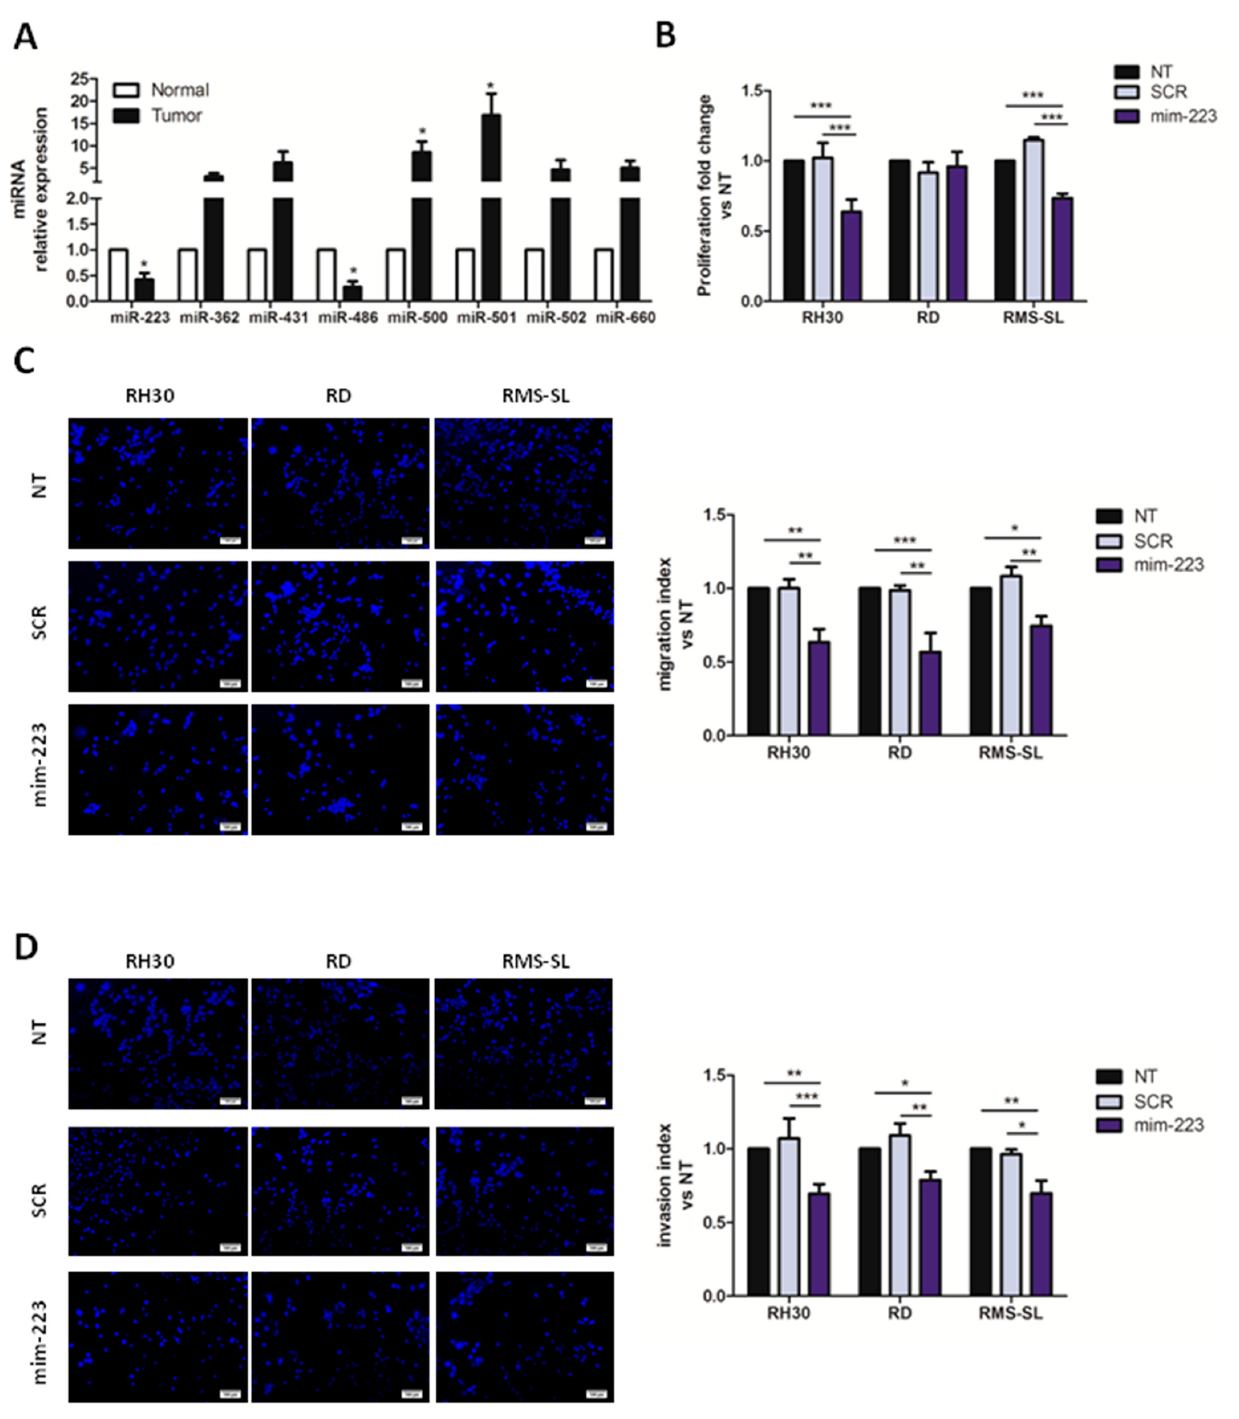
Figure 1. Mir-223 replacement inhibited RMS proliferation and migration. ( A ) Histogram showing miRNAs expression levels in RMS cancers compared to distant normal tissues ( n = 9). * p < 0.05 vs. normal tissues. ( B ) Graph shows cell proliferation of miR-223 over-expressing cells compared to SCR and untreated (NT) control cells ( n = 5). ( C , D ) Representative images and graphs showing of migrated and invaded cells, respectively. MiR-223 reduced migratory ( C ) and invasive ( D ) capacity of adolescent RMS cells in Transwell assay ( n = 5). Migration and invasion data are expressed as number of migrated mir-223 over-expressing cells vs. the number of SCR and untreated (NT) control cells. All data are expressed as mean ± standard error of the mean (SEM). ** p < 0.01, * p < 0.05, *** p < 0.001 vs. SCR or NT